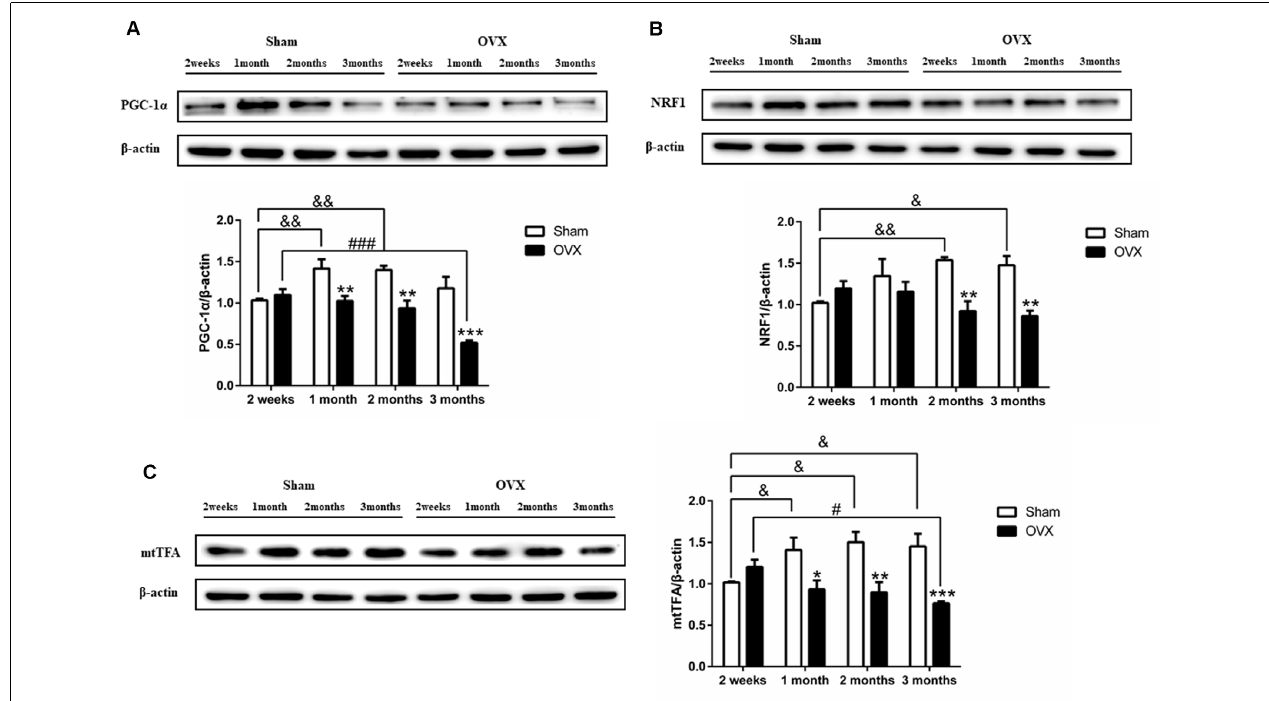
FIGURE 5 | Levels of the mitochondrial biogenesis proteins (A) PGC-1 α , (B) NRF1, and (C) mtTFA in the hippocampus of sham-operated (Sham) and ovariectomized (OVX) mice. Bars represent mean values ± standard error of the mean (SEM). * p < 0.05, ** p < 0.01, *** p < 0.001 compared with the Sham mice at the same timepoint; & p < 0.05, && p < 0.01 compared with the 2 weeks Sham mice; # p < 0.05, ### p < 0.001 compared with the 2-week OVX group ( n =